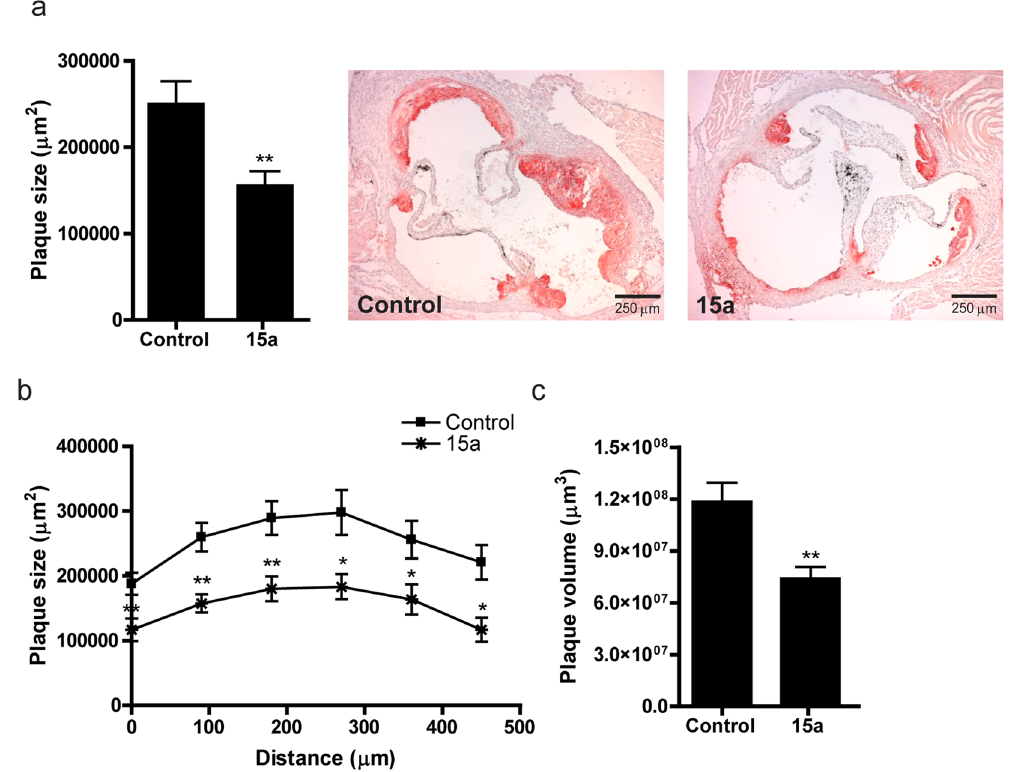
Figure 6. Inhibition of lesion development in the aortic root by 15a. ( a ) Also in the aortic root, 15a inhibited atherosclerotic lesion development after 6 weeks of Western type diet. ( b ) Lesion area in the aortic roots presented for each group every 90 μ m of the aortic root. ( c ) Plaque volume was also significantly reduced in the 15a-treated group. * P < 0.05, ** P < 0.01. Graphs shown are representative from one experiment with n = 10 controls versus n = 9 15a-treated